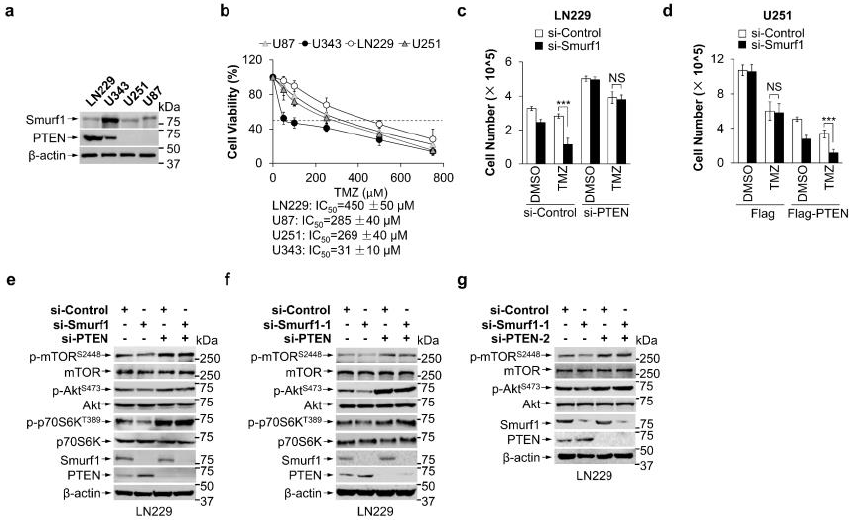
Figure A1. Combination of Smurf1 suppression with TMZ synthetically inhibits PI3K/Akt pathway. ( a ) GB cell lines were prepared for whole-cell lysates and Smurf1 and PTEN examined by immunoblotting with anti-Smurf1 and anti-PTEN antibodies. Blots were probed with anti- β -actin antibody to check protein loading. ( b ) Cell viability was measured after the indicated time treatment with TMZ (48 h, indicated concentration) in different tumor cells (LN229, U343, U251, U87) using MTT assay. ( c , d ) LN229 cells treated with si-Control or si-PTEN ( c ) and U251 cells with Flag or Flag-PTEN ( d ) were transfected with control or Smurf1 siRNA oligos, then treated with DMSO or TMZ (250 µ M, 48 h). The graph shows the number of cells in each group. ( e – g ) LN229 cells were transfected with si-Control, si-Smurf1, si-Smurf1-1, si-PTEN, or si-PTEN-2. Whole-cell lysates were examined by Western blotting with anti-p-mTOR S2448 , anti-mTOR, anti-p-AKT S473 , anti-AKT, anti-p-p70S6K T389 , anti-p70S6K, anti-Smurf1, and anti-PTEN antibodies. Blots were probed with anti- β -actin antibody to check protein loading. In ( a , e – g ), Western blot analysis was performed in n = 3 biological replicates. In ( b – d ), data are presented as mean ± SD of three separate experiments, NS p > 0.05, *** p < 0.001 as determined by unpaired two-tailed Student’s t